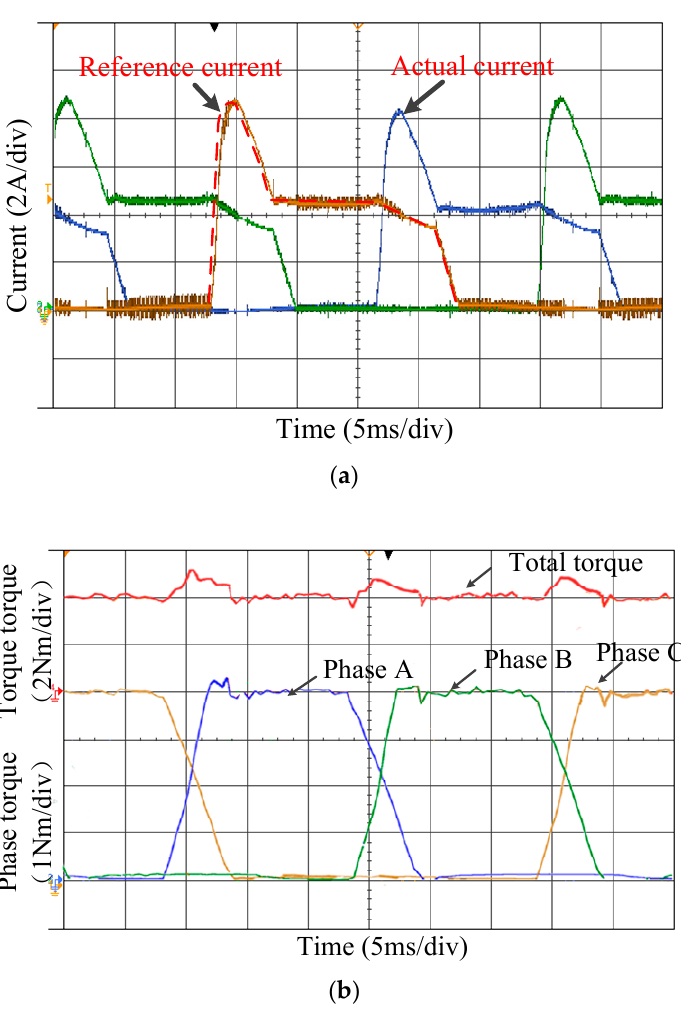
Figure 16. Experiment results with predictive current control method based on linear TSF when the reference torque is set 4 N · m ( a ) Current profile ( b ) Phase torque and Total torque. Energies 2018 , 11 , x FOR PEER REVIEW